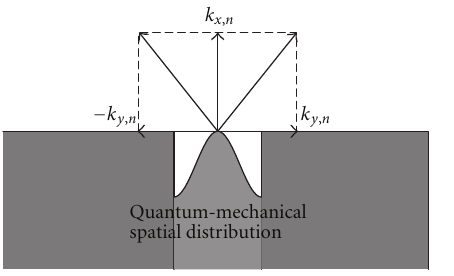
Figure 2: Schematic description of the quantized billiard model. The quantization of momentum of electrons and the quantum- mechanical probability distribution within the emitter are assumed.